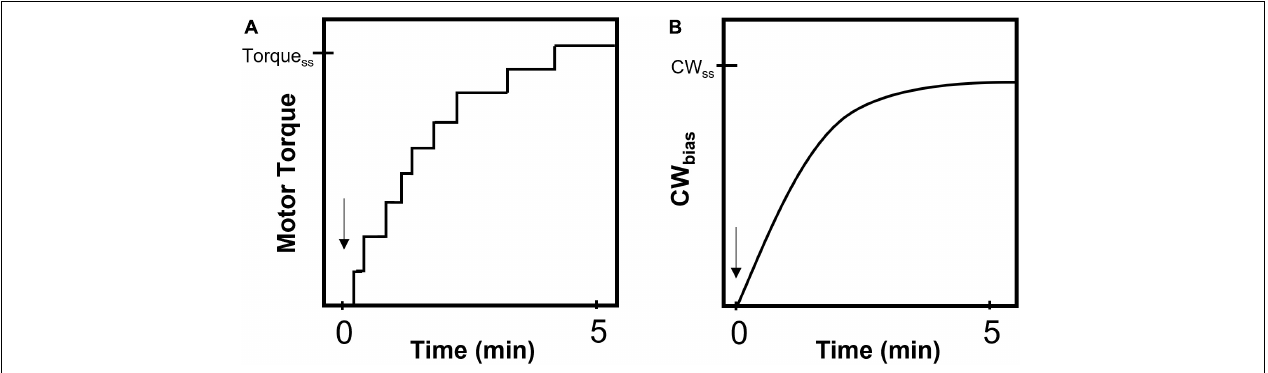
FIGURE 2 | Mechano-response in a flagellar motor. Cartoon representations of the response of a single motor that is mechanically stimulated by suddenly increasing the viscous load (Lele et al., 2013). The arrow indicates the instant of stimulus. (A) The motor responds by recruiting additional stator units resulting in a stepwise increase in torque (and speed). Torque SS indicates the final, steady-state value of torque following the completion of stator recruitment and can range from 2,000 to 4,000 pN.nm under high loads (Berg, 2004). (B) The probability of CW rotation (CW bias ) increases from a very low value to a steady-state or basal value (CW SS ) over a similar timescale as that for stator recruitment. The CW SS value remains constant irrespective of the magnitude of the load-change (Antani et al.,